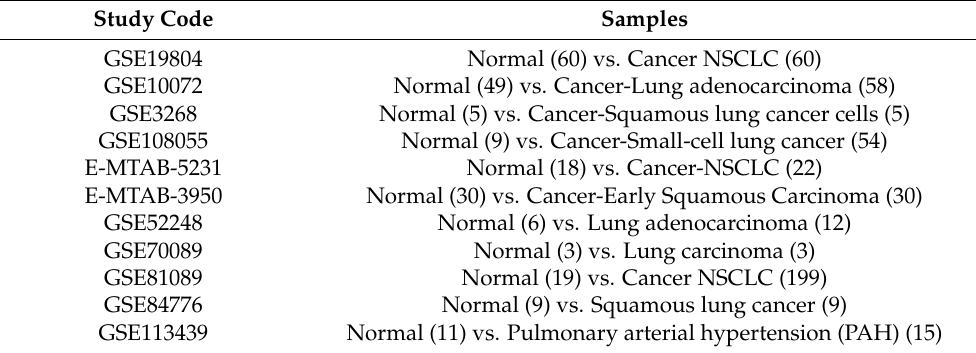
Table 1. Gene expression datasets, each study code, and number of samples. Study